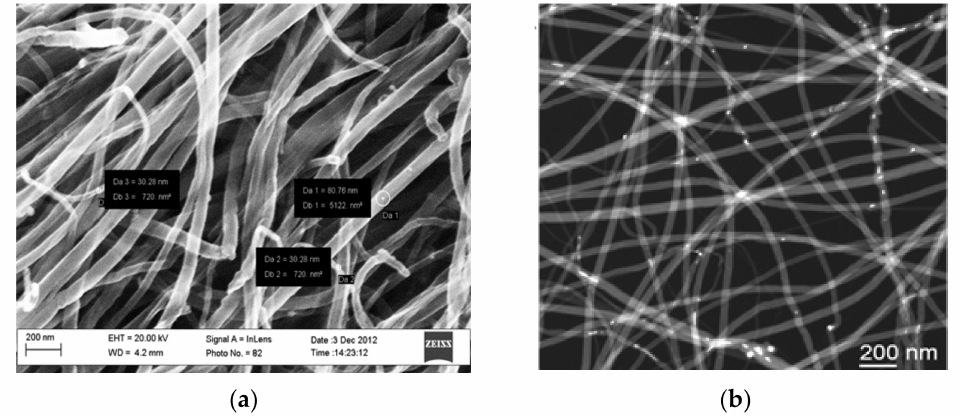
Figure 1. ( a ) Scanning electron microscope and ( b ) transmission electron microscope in scanning mode, 60,000 × high-magnification images of purified